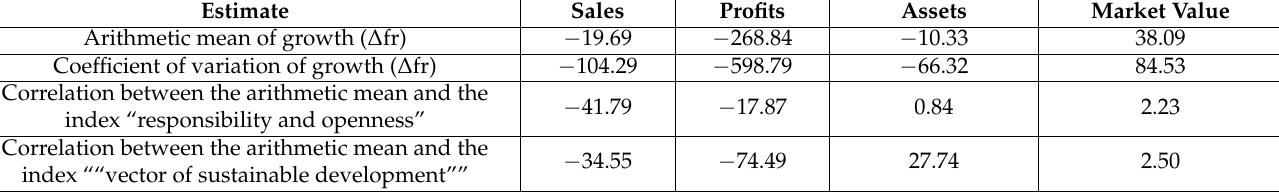
Table 4. Assessment of the impact of CSR on the financial risks of Russian companies in 2021.